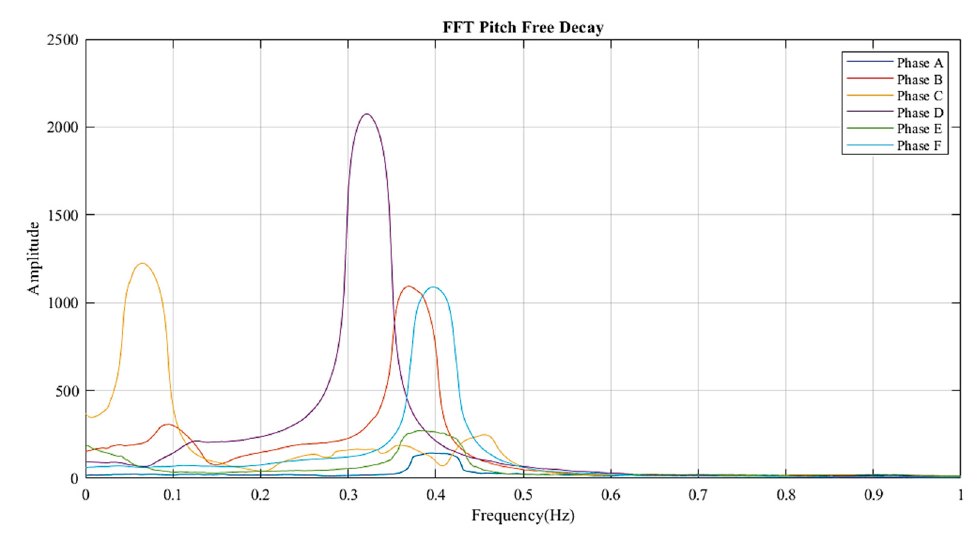
Figure 10. FFT of pitch of free decay for all phases of testing. Table 4. Estimated natural frequency of heave, surge, sway and pitch motions.